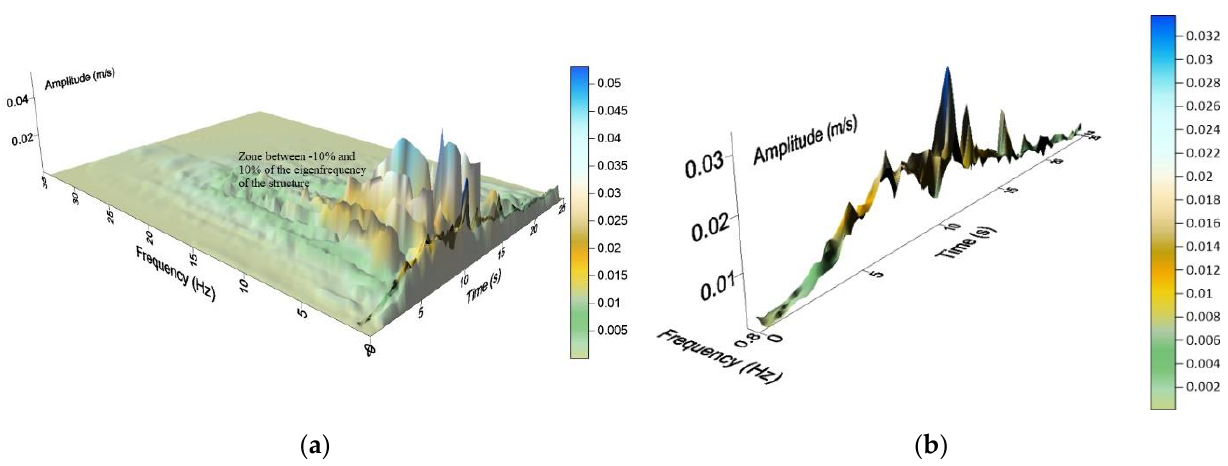
Figure 3. ( a ) Limitation of the HS on the band of frequencies encompassed in the zone between 0.90 and 1.10 of the fundamental frequency f 0 ; ( b ) enlargement of the characteristic zone of HS. All the above parameters were defined for the new limitation of the Hilbert spec- trum and, correspondingly, were assigned as V 2 (HHT) , S 2 (HHT) , A 2 (max,HHT) , A 2 (mean,HHT) , A 2 (dif,HHT) , V 2 (Pos,HHT) and S 2 (Pos,HHT) , VA 2 (max,HHT) , VA 2 (mean,HHT) , VA 2 (dif,HHT) , A 2 (HHT) , and A 2 (Pos,HHT)